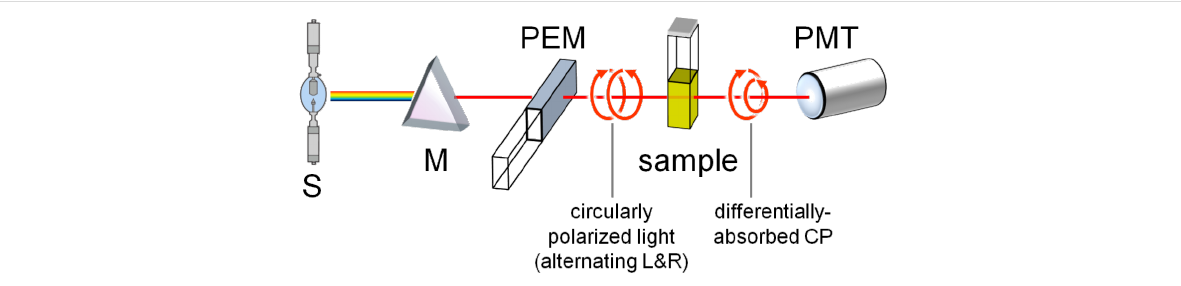
Figure 5: Schematic illustration of an ECD instrument. Legend: S, source; M, monochromator (wavelength selector); PEM, photoelastic modulator producing L-CP and R-CP light alternatively; PMT, photomultiplier (detector). A basic VCD instrument has a similar design, except that the monochro- mator is replaced by an interferometer for Fourier